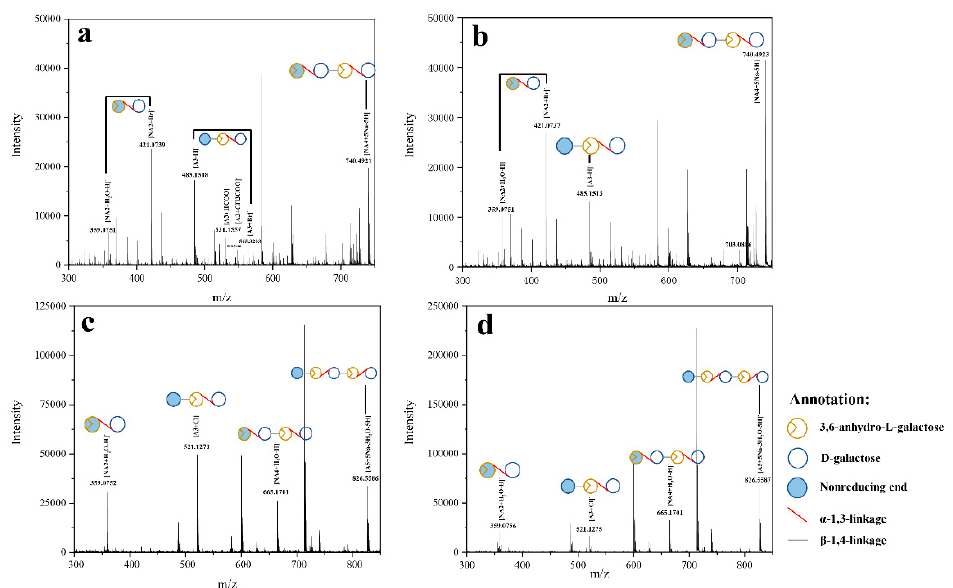
Figure 3. ESI-MS analysis of enzymatic production of agaroheptaose (A7), by AgWH50B ( a ) or DagA ( c ) and agarononoses (A9) by AgWH50B ( b ) or DagA ( d ).